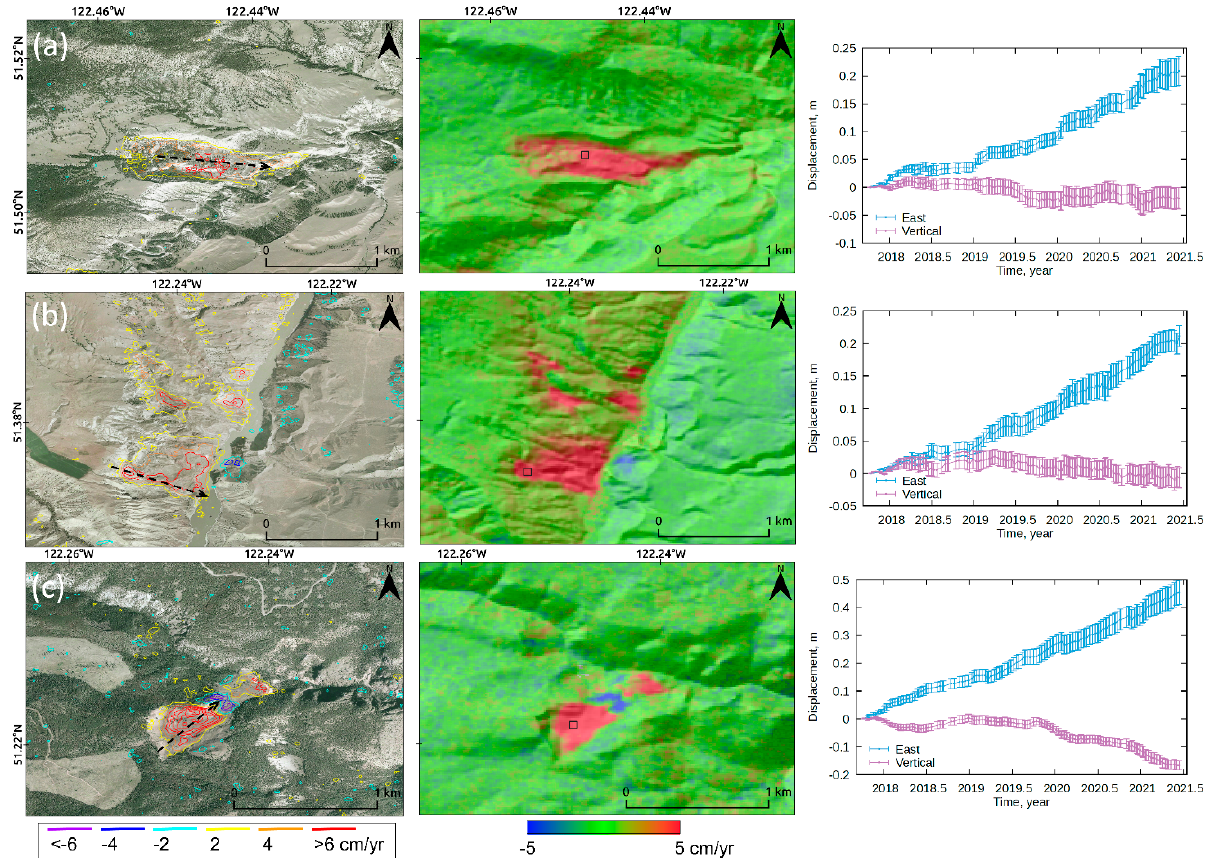
Figure 4. Close-ups of Sites 1–3 ( a – c , respectively) of Google Earth imagery ( left ) and the Sentinel-1 east–west movement map overlaid on the hillshade DEM ( middle ) with Sentinel-1 2D time-series plots ( right ; cumulative east–west (blue) and vertical (purple) movements extracted from 5-by-5 pixels marked in black squares in the middle panels). The color-coded contours and dashed black arrows in the left panels represent the east–west movement rates estimated by Sentinel-1 and the direction of earth flows, respectively. The error bars in the time-series plots represent the standard deviations of the 5-by-5 pixel measurements. Figure 4b shows active slope movements at Grinder Creek [32].